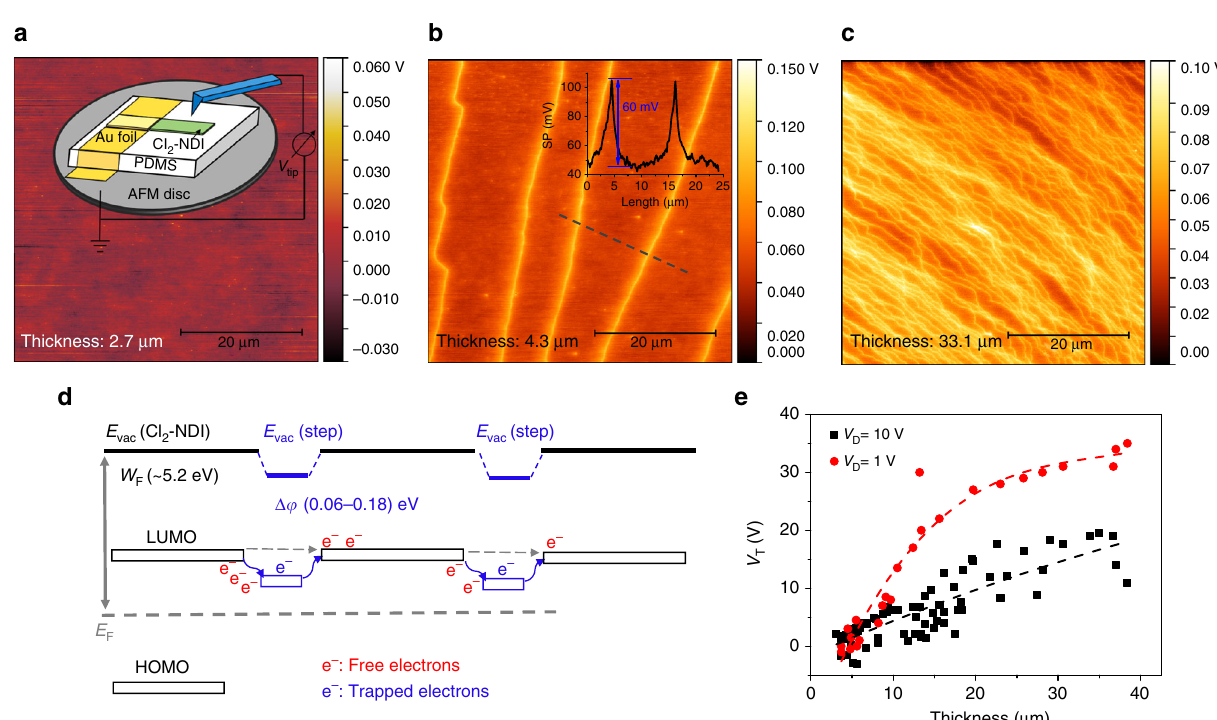
Fig. 4 Surface potential maps of crystal step edges and their role as electron traps. a – c SKPM surface potential images of Cl 2 -NDI single crystals with different thicknesses. Inset to a : schematic diagram of the SKPM measurement. Surface potentials averaging + 60 mV were observed at discrete step edges in b . Inset to b : corresponding surface potential pro fi le along the gray dashed line. The thicknesses of crystals were 2.7, 4.3, and 33.1 µ m for a , b , c , respectively. d The proposed energy level diagram for step edges on the surface of Cl 2 -NDI single crystals. E F is the Fermi level and E vac is vacuum level. The work function of Cl 2 -NDI single crystal is ~5.2 eV. At the step edge, the vacuum level shifts about 0.06 – 0.18 eV compared to the surrounding surface by SKPM measurement. e The threshold voltage as a function of crystal thickness at V D of 10 V (74 devices) and 1 V (25 devices), respectively. The increase in V T with crystal thickness is indicative of increased electron